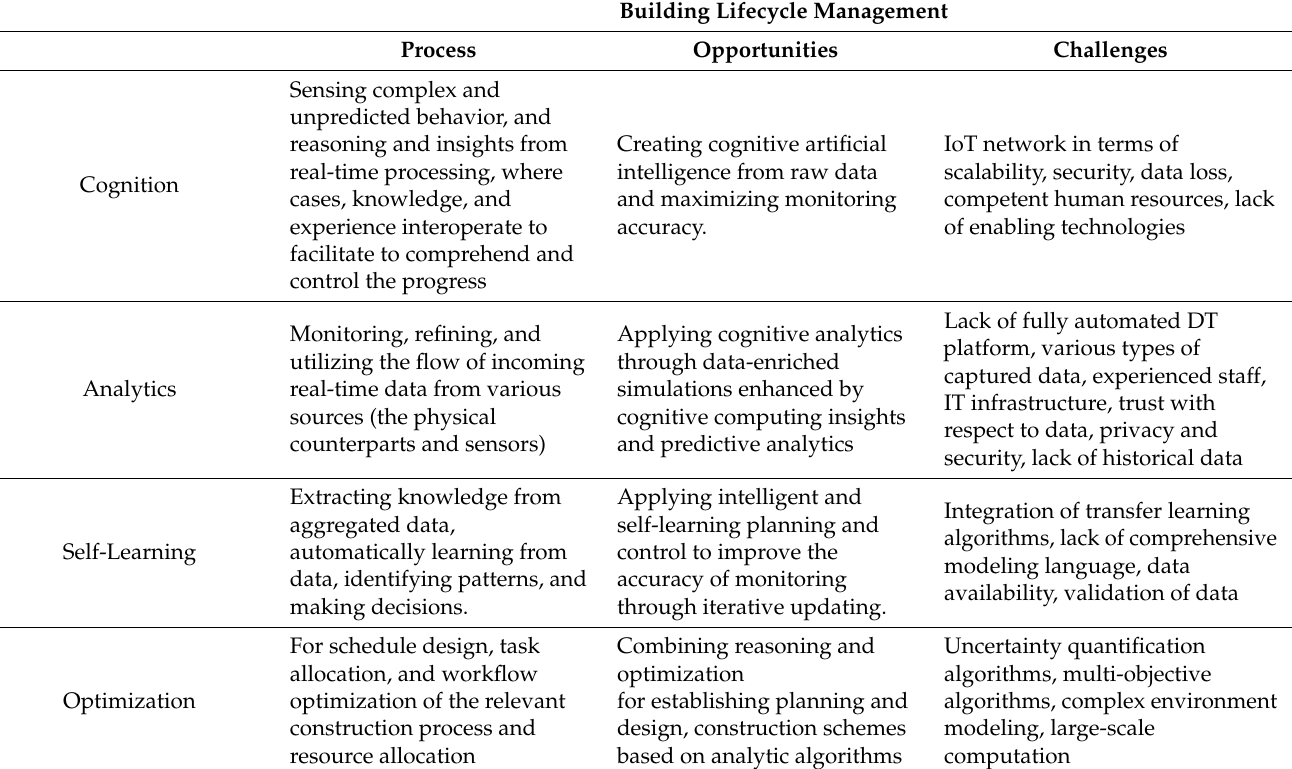
Table 6. Sample of Cognitive Digital Twins cognition, analytics, and optimization processes in Building Lifecycle